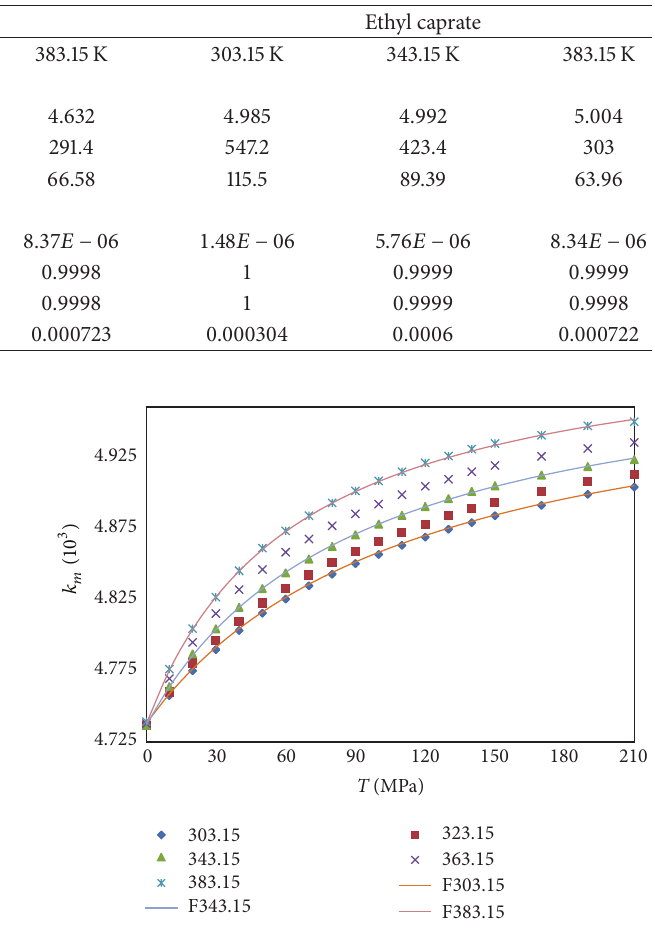
Table 2: Fitting coefficients for (9) along various isothermals.